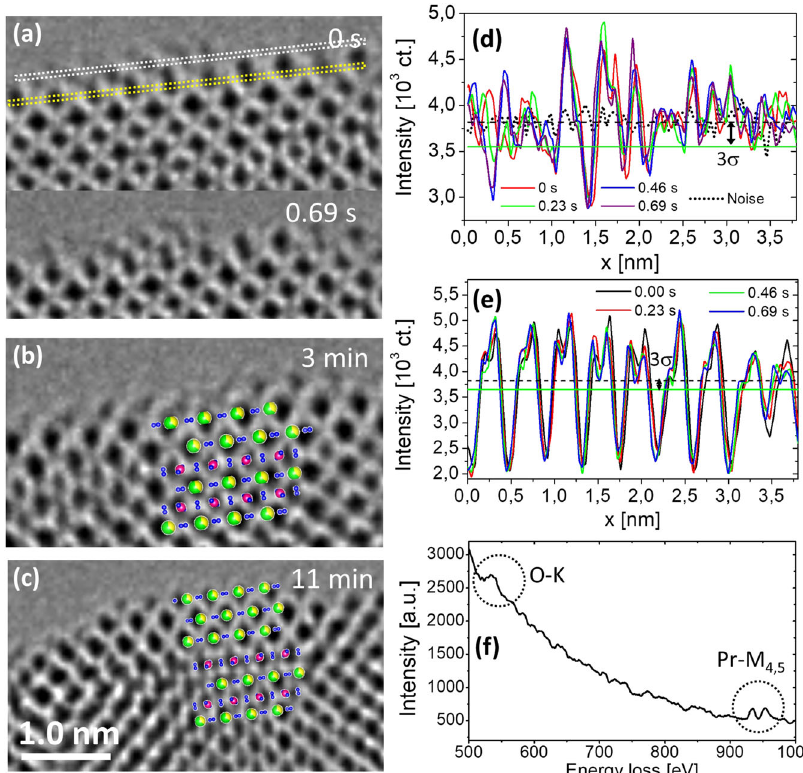
Fig. 5 Atomic surface dynamics of the PCMO (001) surface in 0.5 Pa H 2 O. a HRTEM images taken from a time series taken at a rate of 4 fps at [110] zone axis and negative defocus, compiled in Movie M06. b , c Later stages of that surface area at same conditions. The line pro fi les are taken at the B-site ( d ) and A-site ( e ) columns. Whereas the A-site columns of the fi rst subsurface layer remain ordered ( f ), the B-site columns transform into a dynamical highly disordered surface structure. The measured hopping rate of Mn adatoms is r ≥ 4 s − 1 , from triple Mn coincidence occupation. In addition to surface movement, there is a pronounced leaching of Mn from the subsurface to the surface leading to the growth of a Pr-rich surface layer, where Mn L 3,2 is below the detection limit ( f